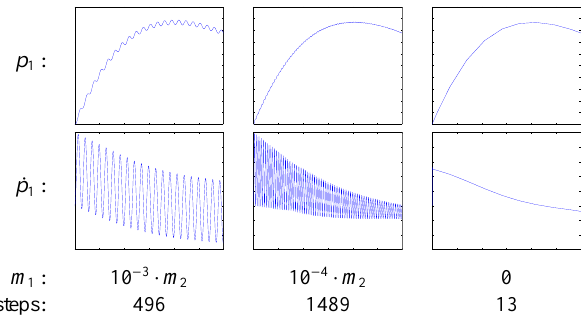
Figure 2. Oscillations and number of time steps for decreasing mass ratios m 1 / m 2 (BDF solver DASSL with tolerances 10 − 6 for absolute and relative errors), see Burgermeister et al.